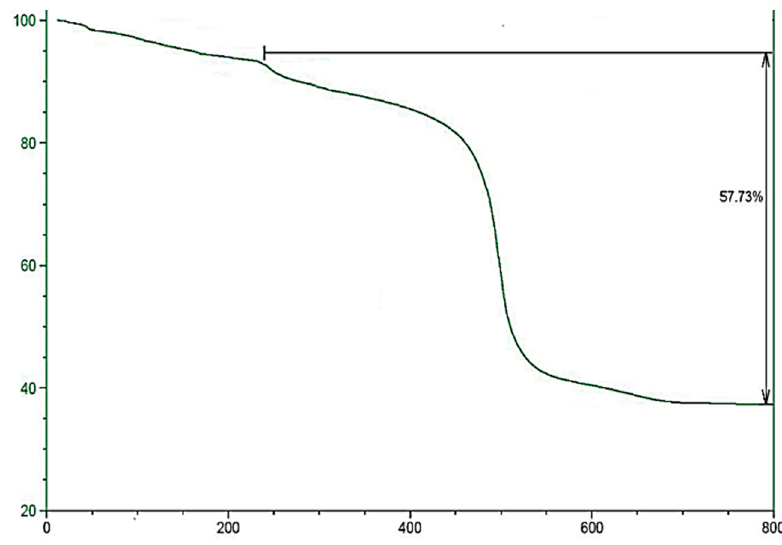
Figure 4. Thermogravimetric analysis of Cu-L@SBA-15.